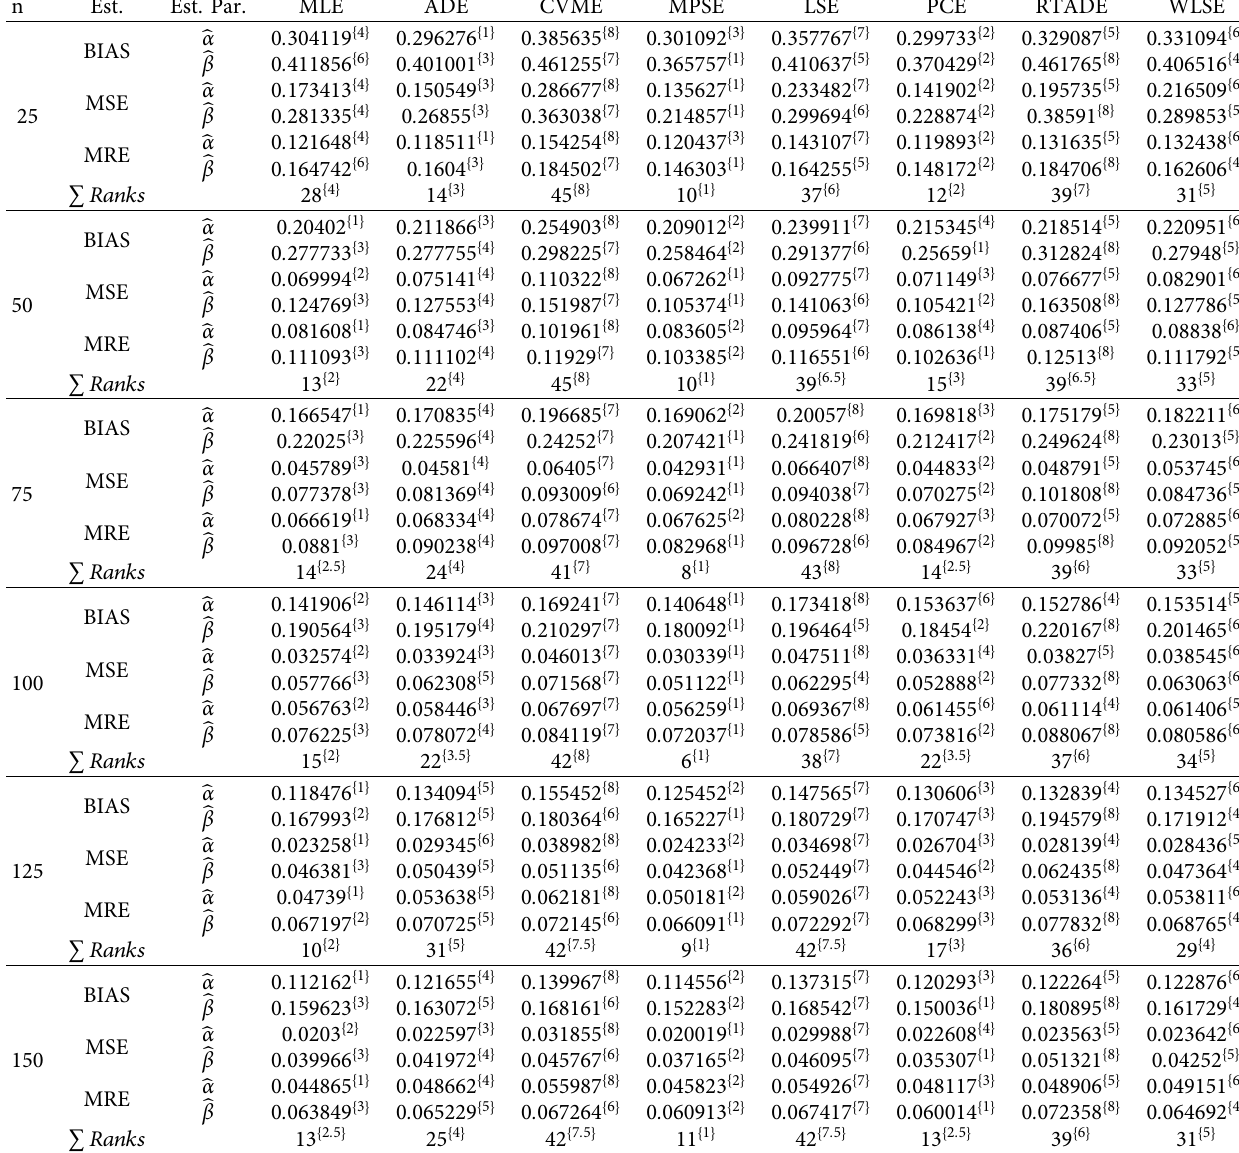
Table 4: Simulation values of BIAS, MSE, and MRE for α � 2 . 5 , β � 2 .